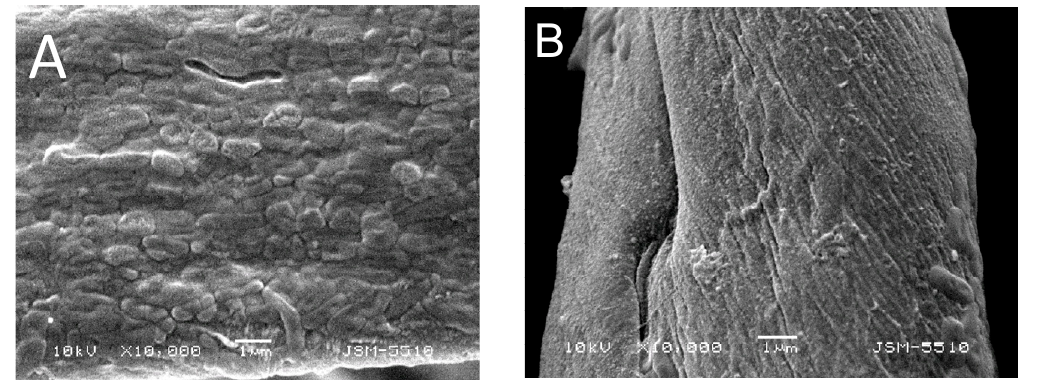
Figure 6. SEM images of cotton fabrics tested against P. aeruginosa at magnification ×10000: ( A ) the biofilm on cotton textile treated with D16 and ( B ) the absence of biofilm on a cotton textile treated with Zn 4 (D16)(NO 3 ) 8 .